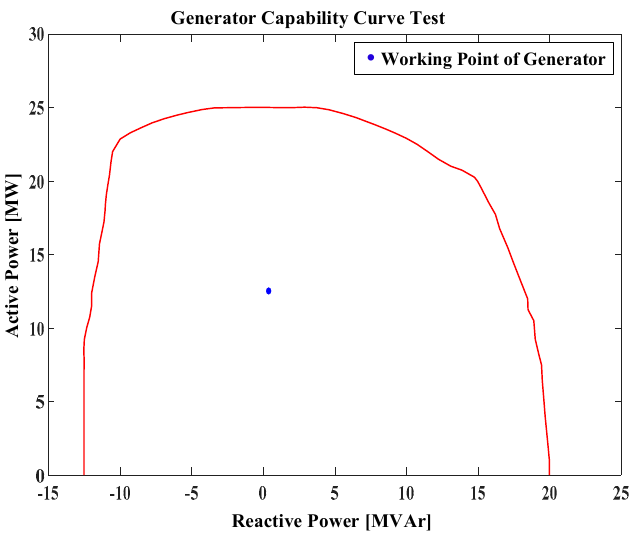
Figure 15. The developed capability curve of a generator of neural network training.